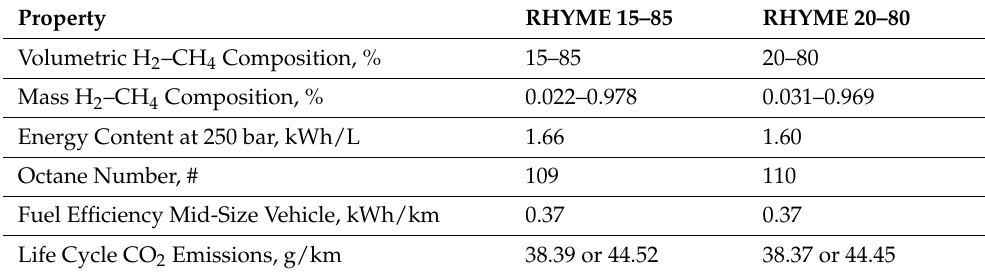
Table 8. Characteristics of the RHYME 15–85 and RHYME 20–80 fuel relevant to